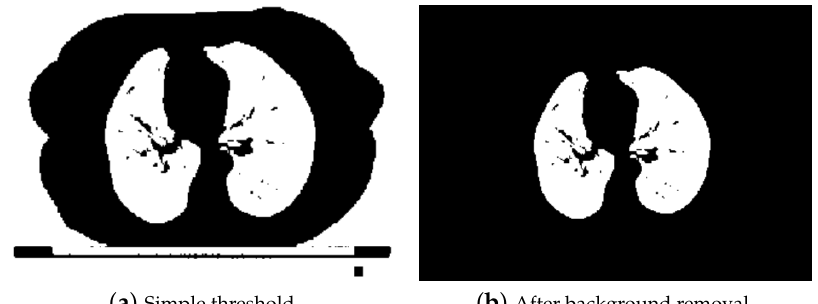
Figure 7. First steps of segmentation.